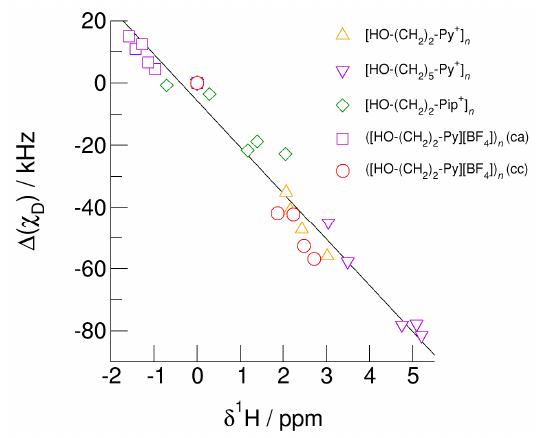
Figure 16. Relation between deuteron quadrupole coupling constant differences, ( χ D ), of the hydroxyl deuterons and proton chemical shifts, δ 1 H, of the hydroxyl protons in cationic clusters [HO-(CH 2 ) 2 -Py + ] n (triangles up), [HO-(CH 2 ) 5 -Py + ] n (triangles down), [HO-(CH 2 ) 2 -Pip + ] n (diamonds), ([HO-(CH 2 ) 2 -Py][BF 4 ]) n (c–a) (squares), and ([HO-(CH 2 ) 2 -Py][BF 4 ]) n (c–c) (circles) each compared to the monomer values. Whether we use different cations and alkyl chains in the cationic clusters or (c–a) and (c–c) hydrogen bonding in the neutral clusters ([HO-(CH 2 ) 2 -Py][BF 4 ]) n (c–c) and ([HO-(CH 2 ) 2 -Py][BF 4 ]) n (c–a), the spectroscopic properties show a universal linear behavior. Easy access to NMR proton chemical shifts allows reliably predicting deuteron quadrupole coupling constants that are usually unknown for clusters and the bulk liquid phase.